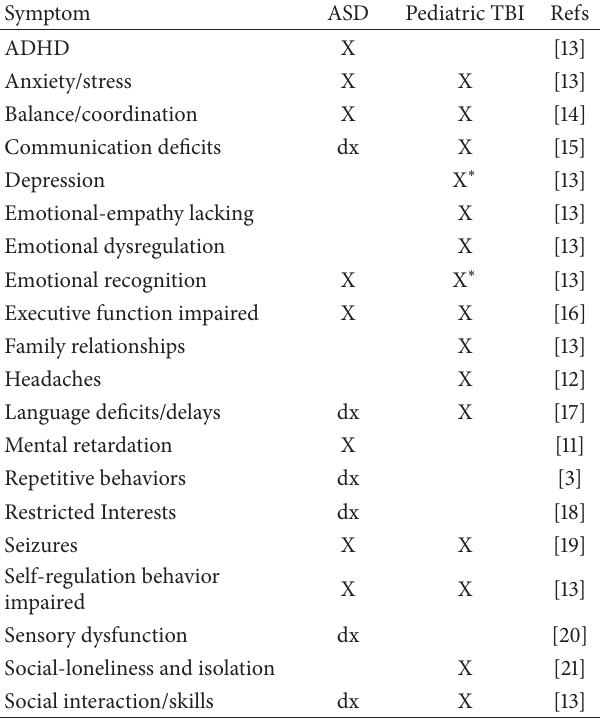
Table 1: Shared behavioral symptoms between ASD and pediatric